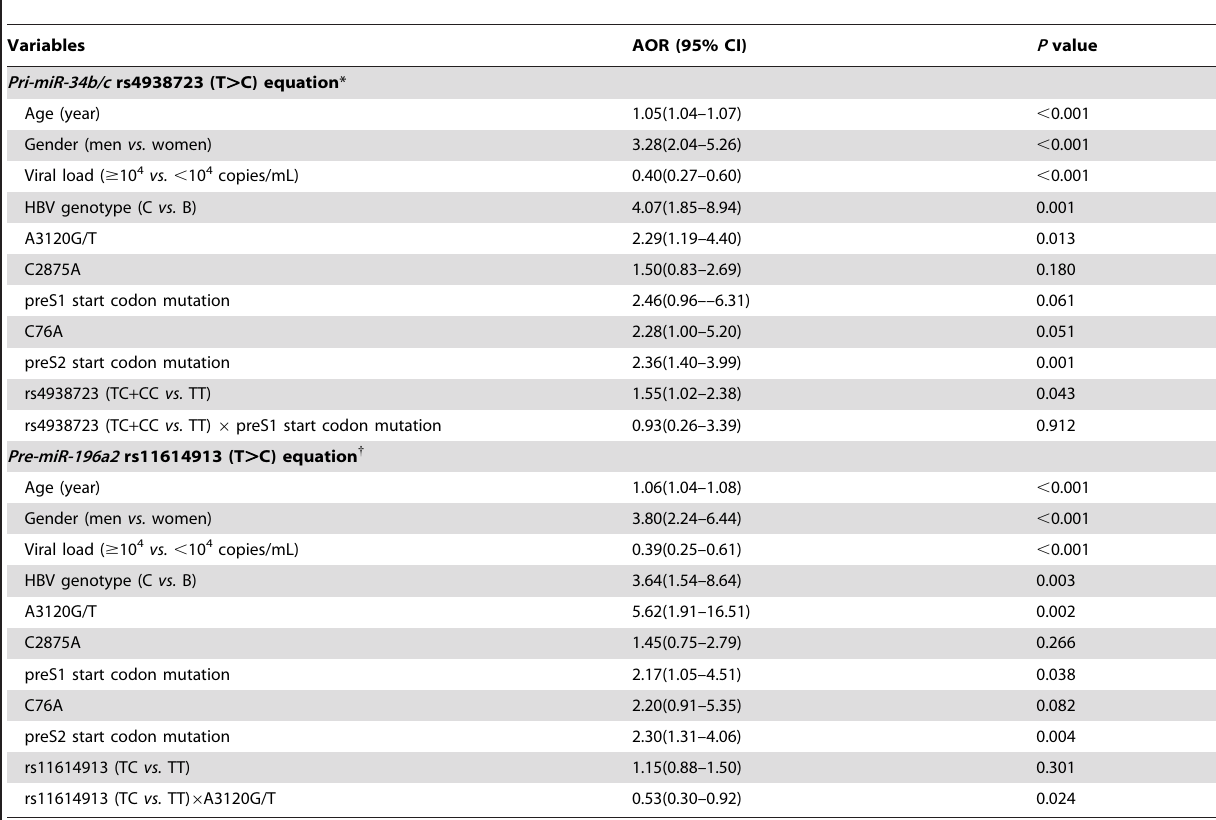
Table 5. Contributions of miRNA polymorphisms and their interactions with the HBV mutations in the preS region to HCC risk in multivariate regression